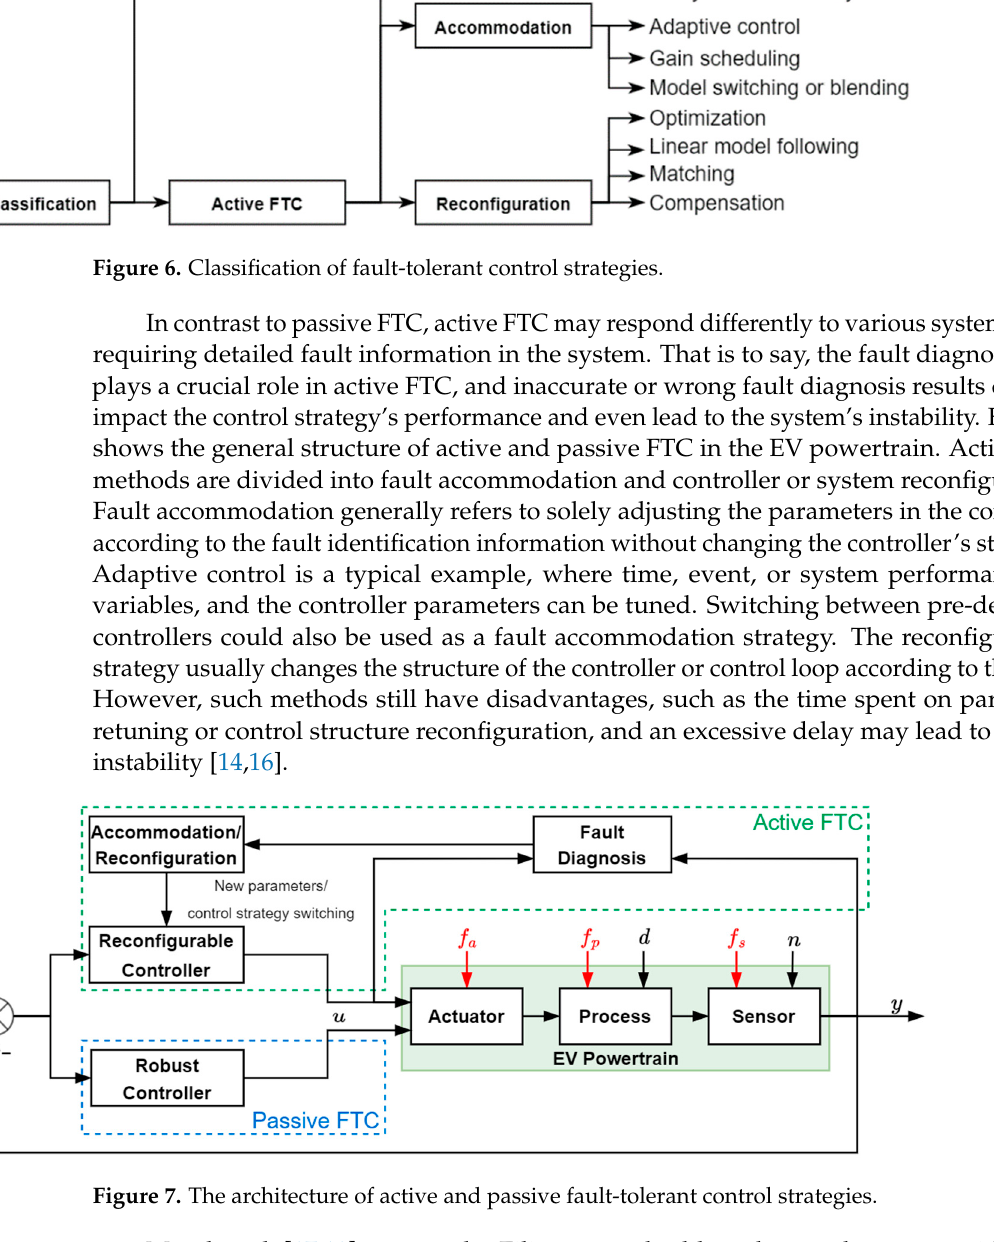
Figure 6. Classification of fault-tolerant control strategies.